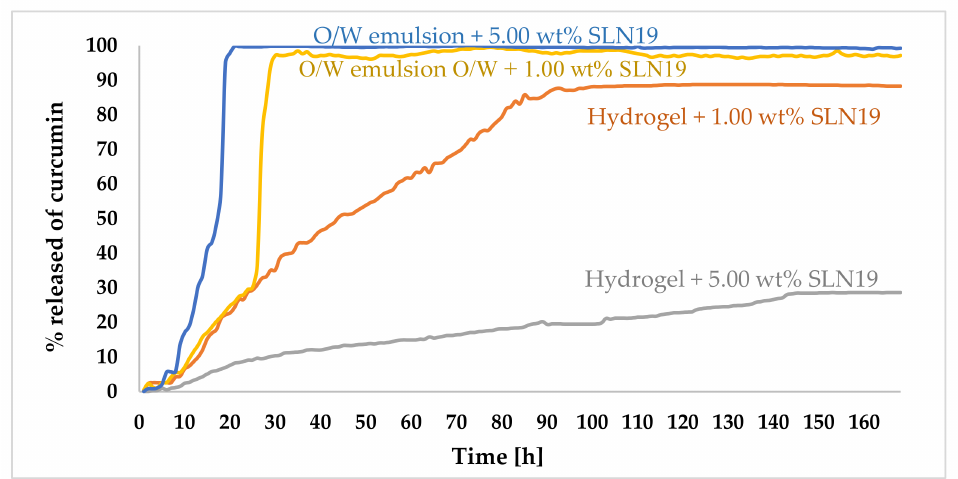
Figure 8. Release profile of curcumin from cosmetic formulations: hydrogel 1.00 wt.% SLN19; hydrogel 5.00 wt.% SLN19; emulsion o/w 1.00 wt.% SLN19; and emulsion o/w 5.00 wt.% SLN19 in phosphate buffer pH